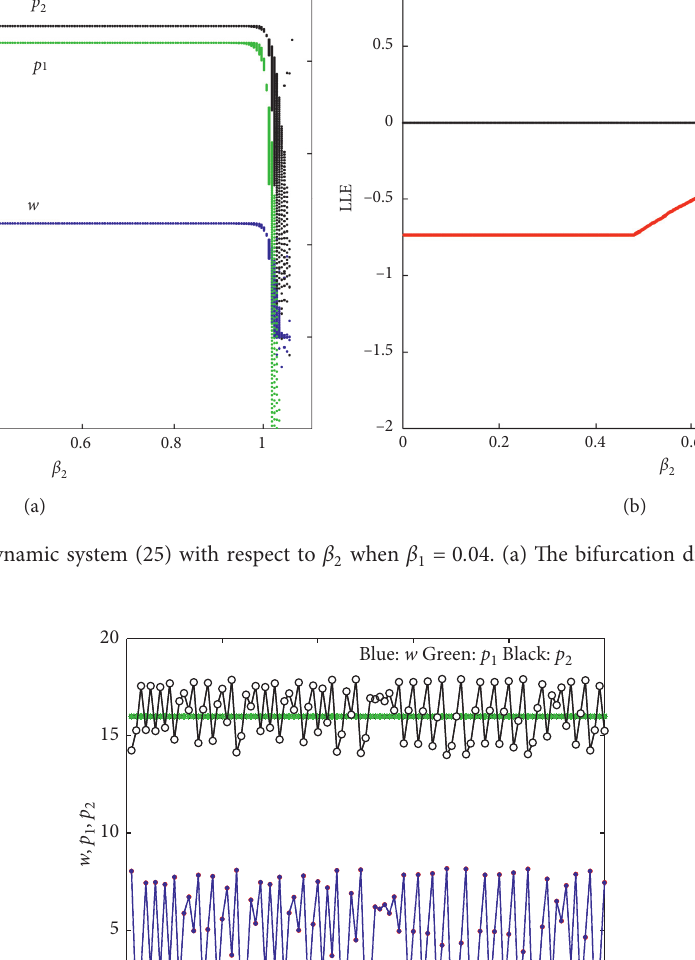
� 0 . 08 and β with β 2 1